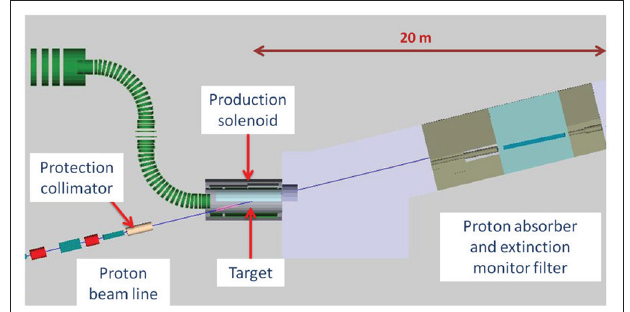
FIGURE 8 | Location of the downstream extinction monitor. From Bartoszek et al.